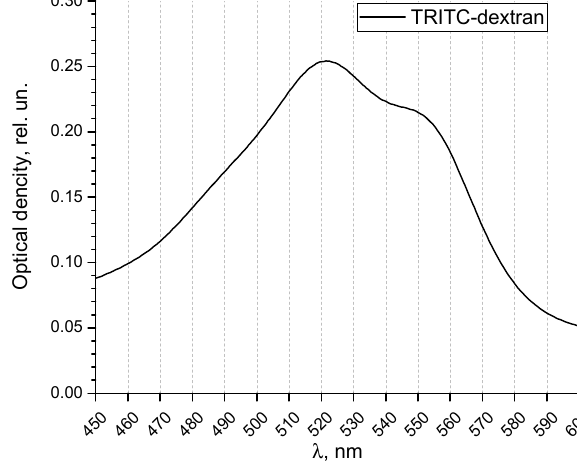
15 of 19 Figure A2. A schematic presentation of Astra-M-Sp instrument for LFMF generator. The set-up con- tains an original electromagnet with a thermostatic sample volume for a standard photometric cu- vette. The electromagnet is connected to the AC generator (California Instruments 2001RP), which can supply 12 A current through the winding. As a result, a sinusoidal magnetic field forms inside